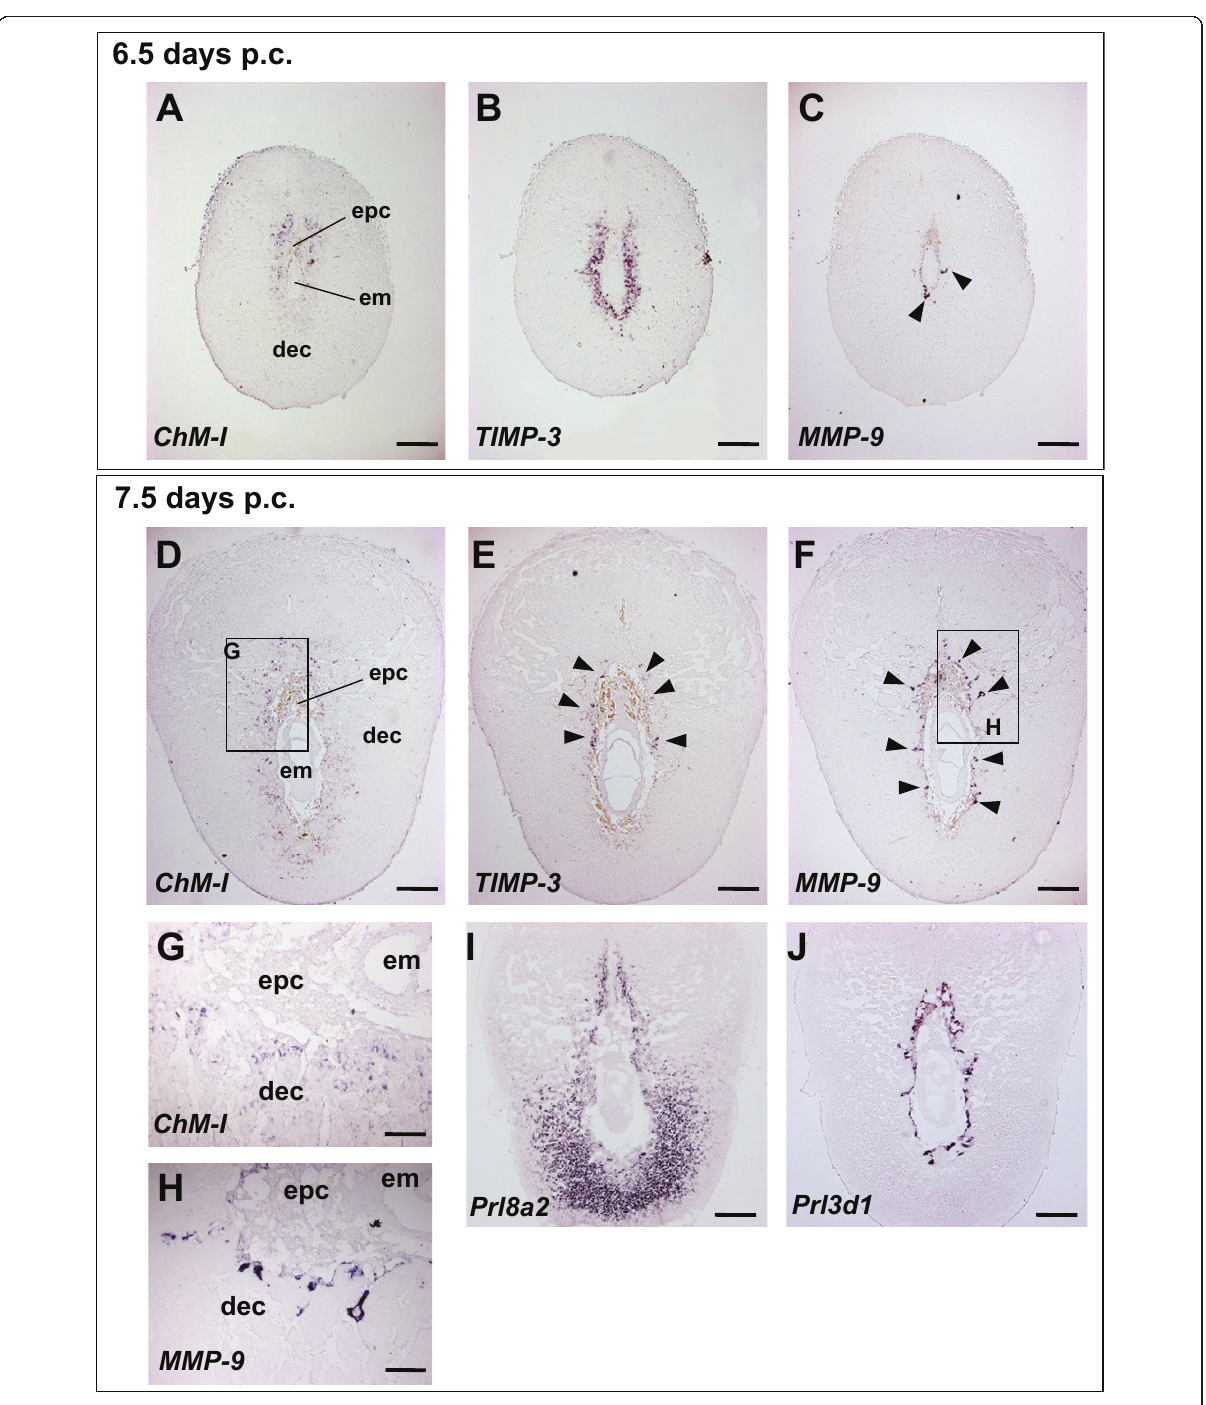
Figure 2 Localization of ChM-I transcripts in the decidua . Expression of ChM-I (A, D, and G), TIMP-3 (B and E), and MMP-9 (C, F, and H) transcripts analyzed by in situ hybridization using semi-serial sections of 6.5 (A-C) and 7.5 (D-F) days p.c. mouse decidual capsules. Expression of Prl8a2 (I) and Prl3d1 (a marker for trophoblasts; J) transcripts were also examined at 7.5 days p.c. Boxed areas in panels D and F are magnified in panels G and H, respectively. Note that, at 7.5 days p.c., ChM-I transcripts were broadly detectable in the primary decidua surrounding the implanting embryo and in MMP-9 -positive cells (arrowheads in panel C and F), whilst TIMP-3 transcripts (arrowheads in panel E) were marginally detected at the mesometrial side. All images are representative of at least three independent experiments. epc , ectoplacental cone; em , embryo; dec , decidua. Bars in panels A-F and I-J, 300 μ m; bars in panels G-H, 100 μ